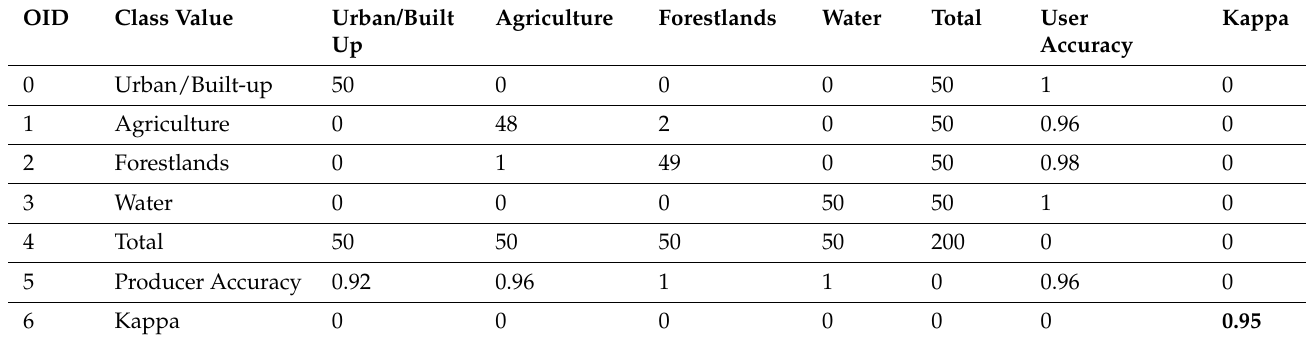
Table A1. User, Producer, and Kappa statistics for the classified image of 1986.